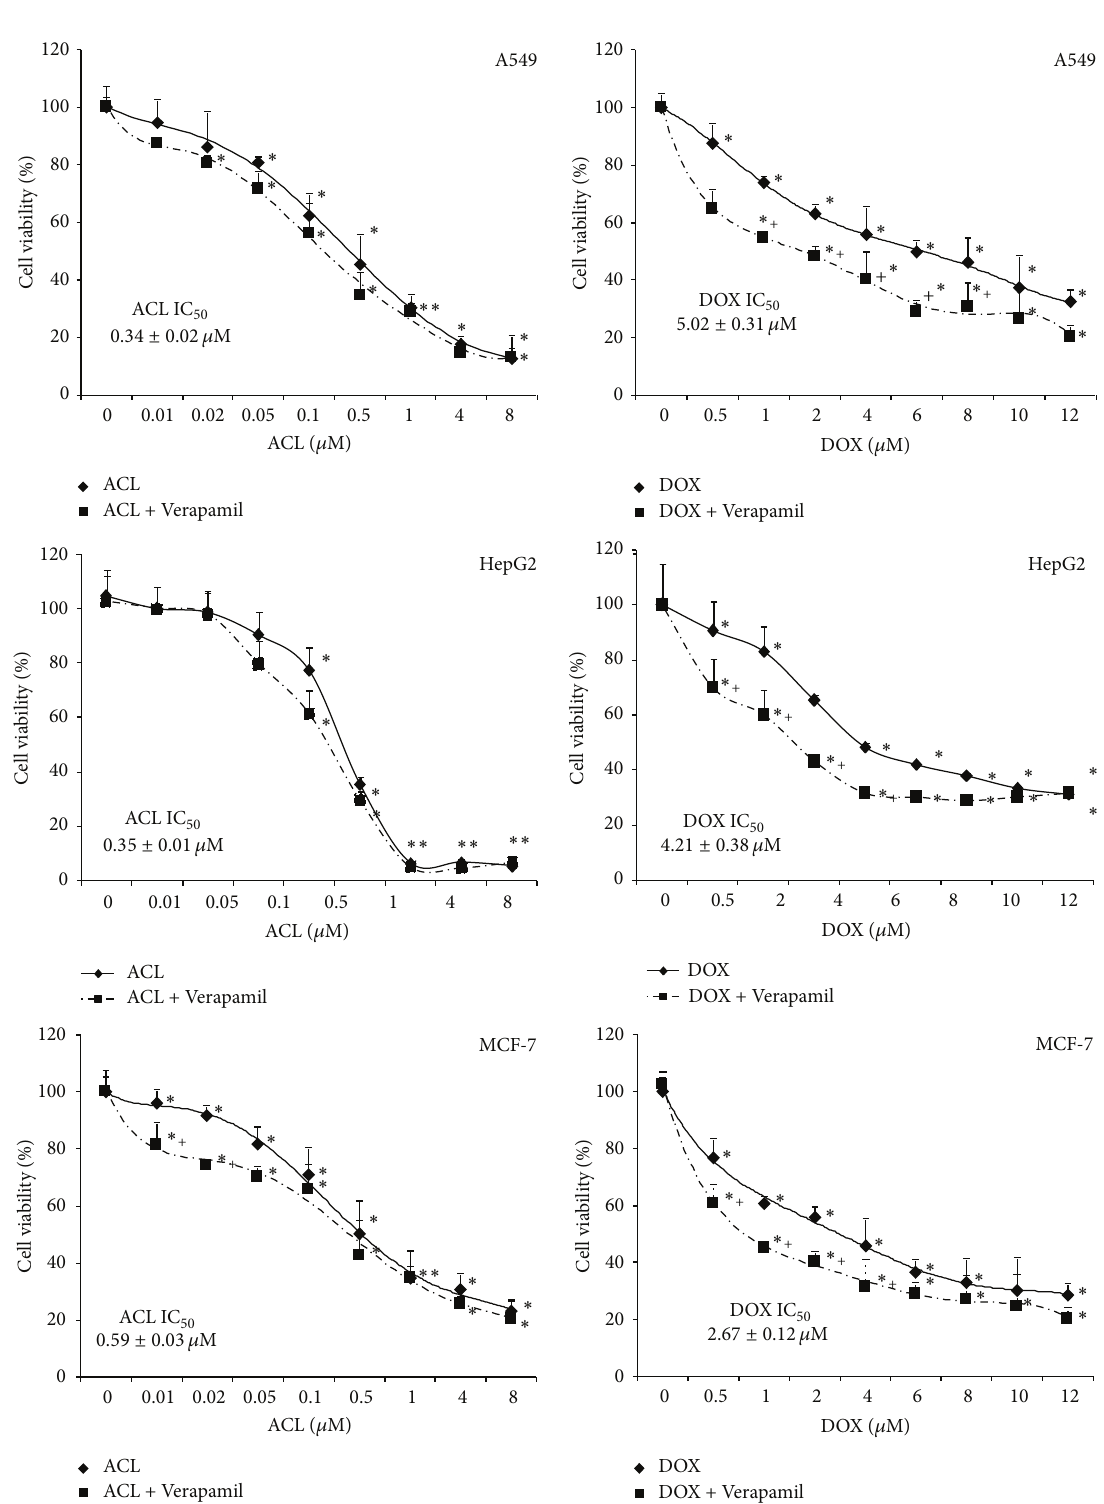
Figure 1: Representative dose-response curves following exposure to DOX and ACL of A549, HepG2, and MCF-7 cells. The evaluation of cell survival was assessed by MTT assay. ∗ 𝑃 < 0.05 , the effect of DOX and ACL on the viability of solid tumor cells. + 𝑃 < 0.05 , changes between the probes preincubated with Verapamil. The values are the mean ± SD of four independent